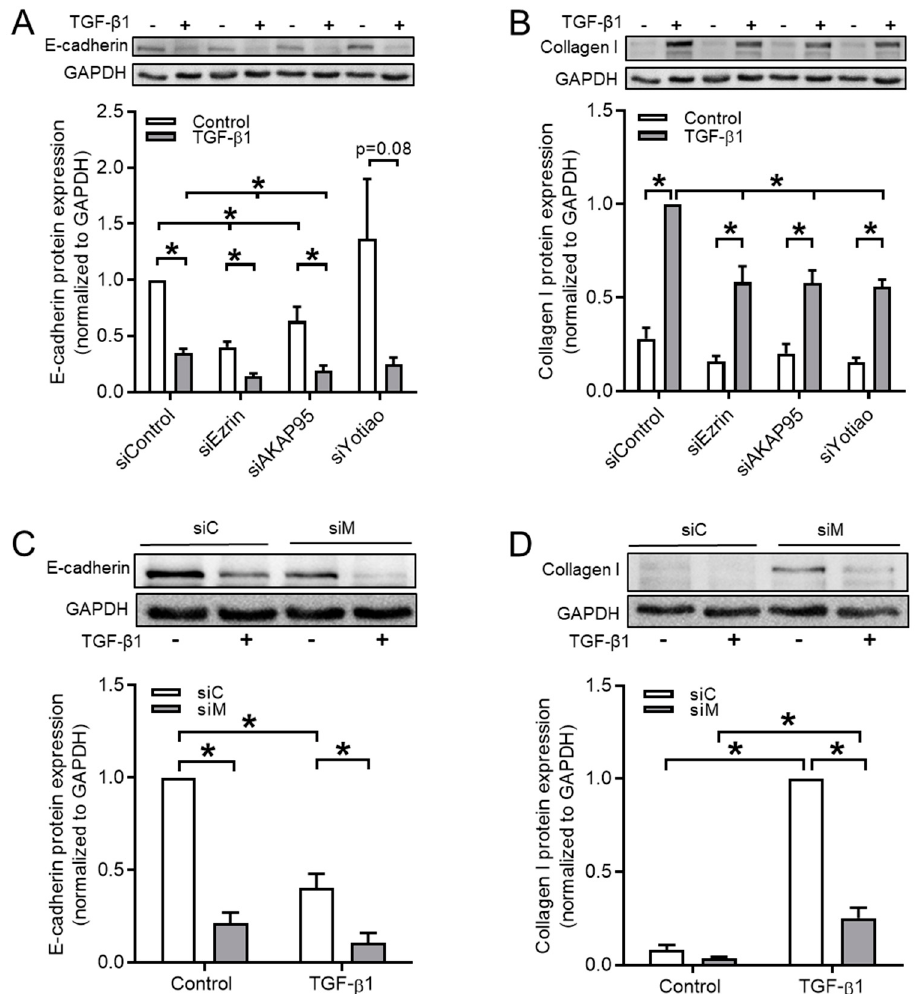
Figure 5. Silencing of Ezrin, AKAP95, and Yotiao diminished TGF- β 1-induced collagen Ӏ upregulation. ( A , B ) Representative western blotting images and quantification of E-cadherin ( A ) and collagen Ӏ ( B ) in cells transfected with the siRNA of Ezrin, AKAP95 or Yotiao in combination with TGF- β 1 treatment. ( C , D ) Representative western blotting images and quantification of E-cadherin ( C ) and collagen Ӏ ( D ) in cells transfected with a combination siRNA of Ezrin, AKAP95, and Yotiao together with TGF- β 1 treatment. siC, control siRNA; siM, multiple silencing siRNA (Ezrin-AKAP95-Yotiao). Data represent 4–6 independent experiments. The data are expressed as mean ± SEM, * p < 0.05; significant difference between indicated groups.